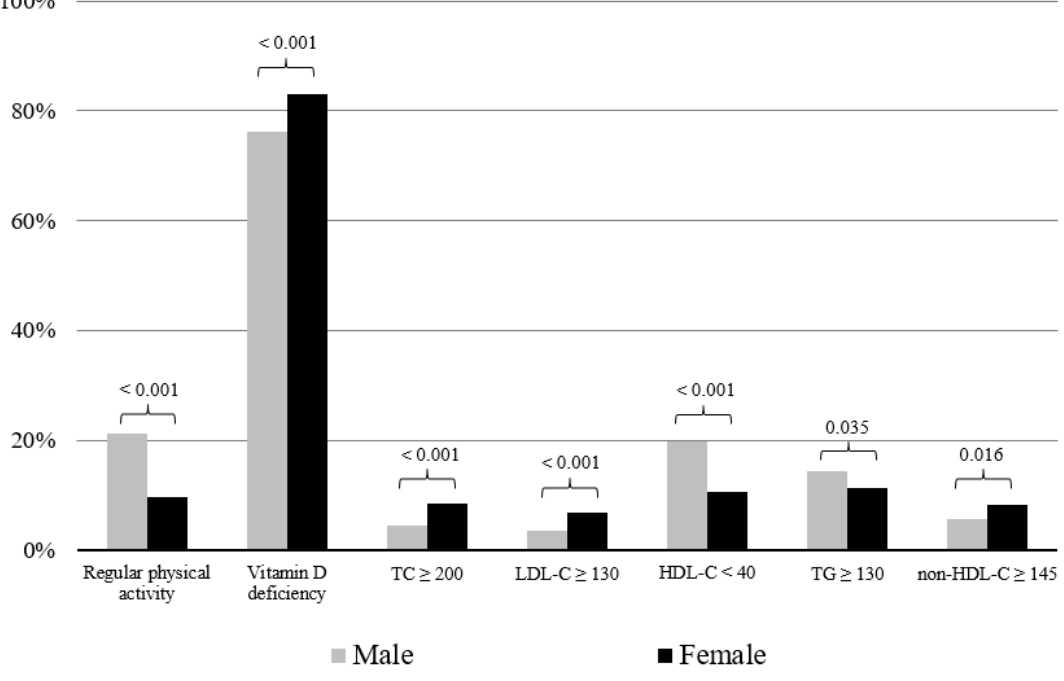
Figure 2. Percentage of subjects with regular physical activity, vitamin D deficiency, and dyslipidemia according to sex. The p -value of each independent t-test is presented above the bars. Regular physical activity was defined as moderate or vigorous physical activity for at least 1 hour/day 7 days/week.